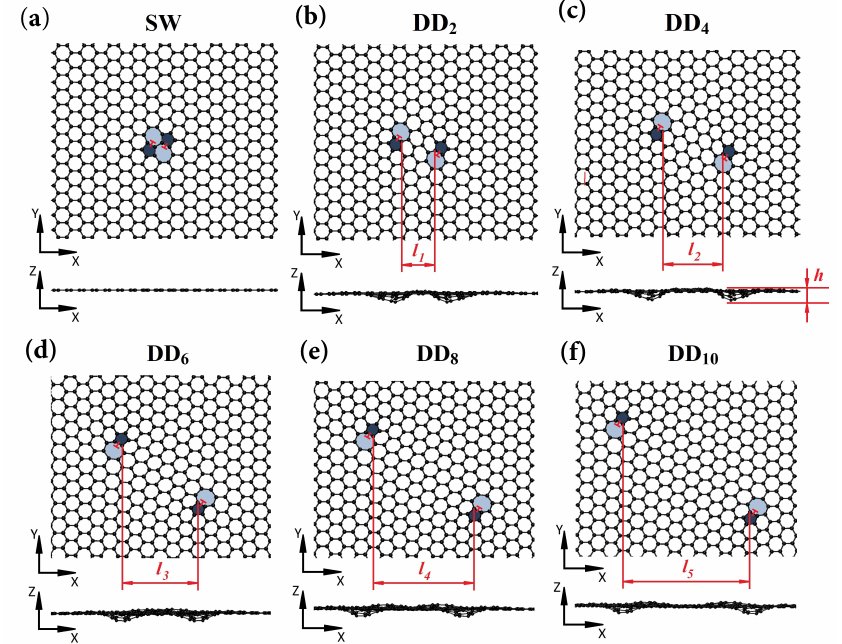
Figure 1. Typical structures of graphene in two projections: ( a ) graphene with SW defect, ( b – f ) graphene with dislocation dipole DD n with the different arm. Geometrical parameters for dipoles are presented in Table 1. Pentagons and heptagons are colored in dark and light blue, respectively. Table 1. Values of dipole arm l and buckling height h for graphene with SW and DD n .